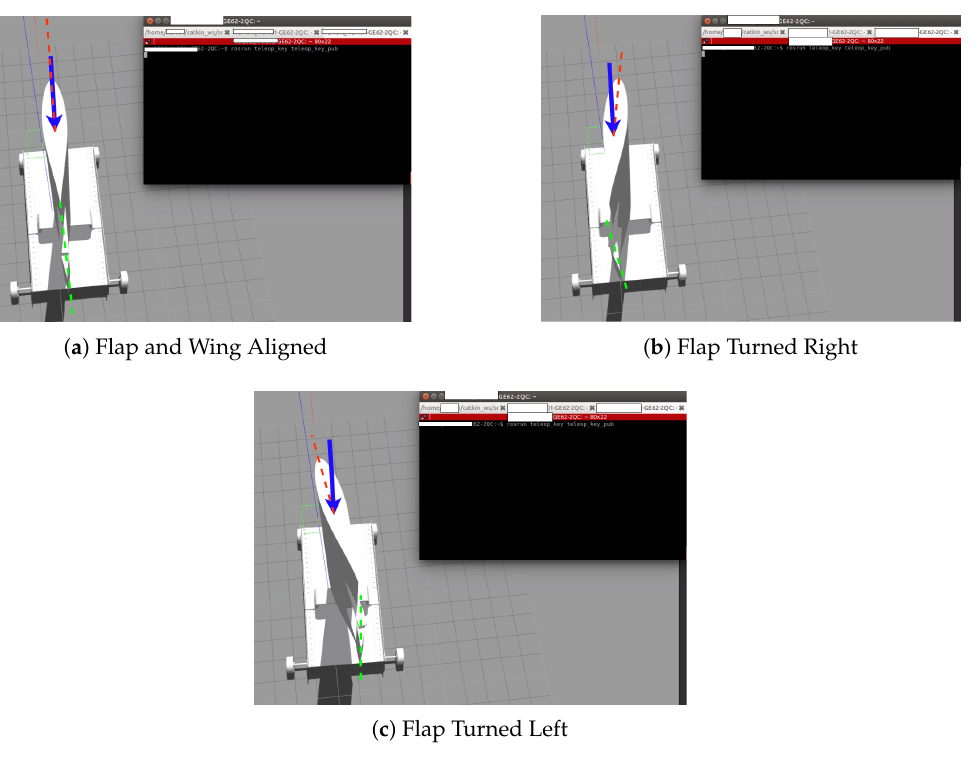
Figure 11. Wing sail response to flap angle changes (8 kn). The wing sail responded correctly to the flap angle change. It turned to the right when the flap angle was set to the left, and to the left when the flap angle was set to the